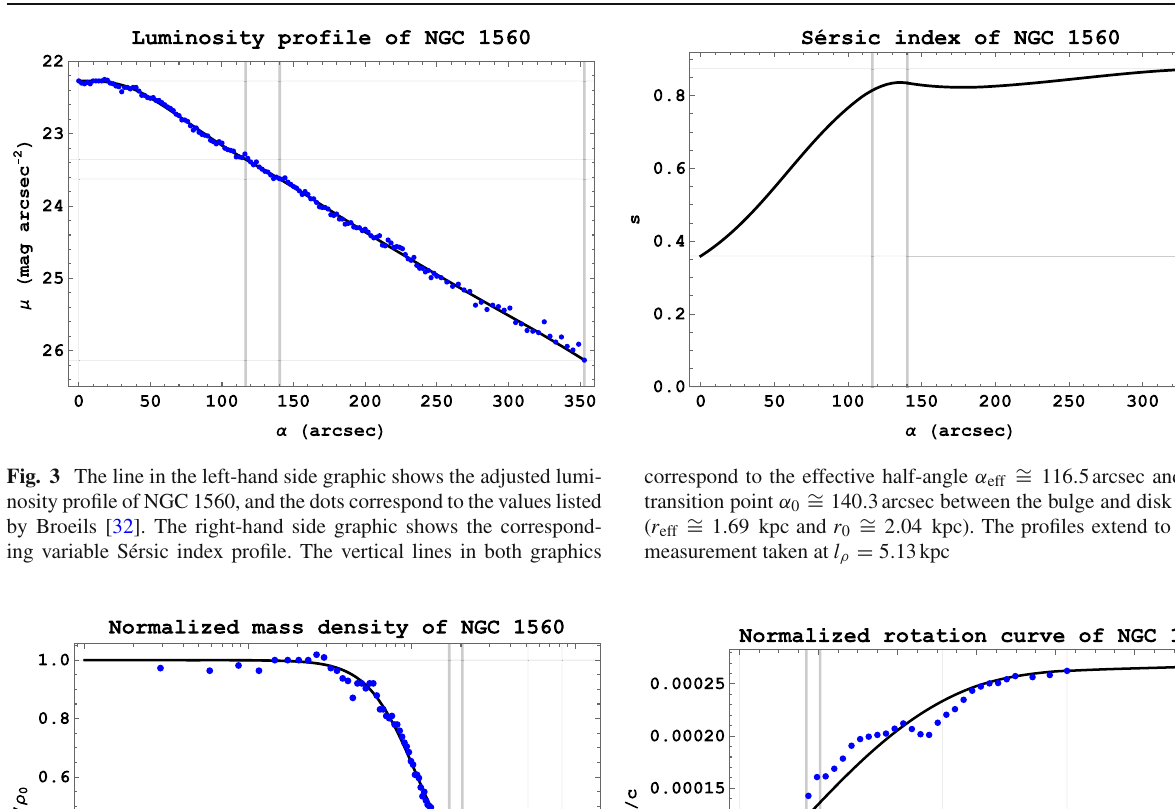
lines correspond to the effective half-radius r eff ∼= 1 . 69 kpc and to the transition point r 0 ∼= 2 . 04 kpc between the bulge and disk regions. The mass density at the radial position r eff is equal to 1 / e times the density at the origin